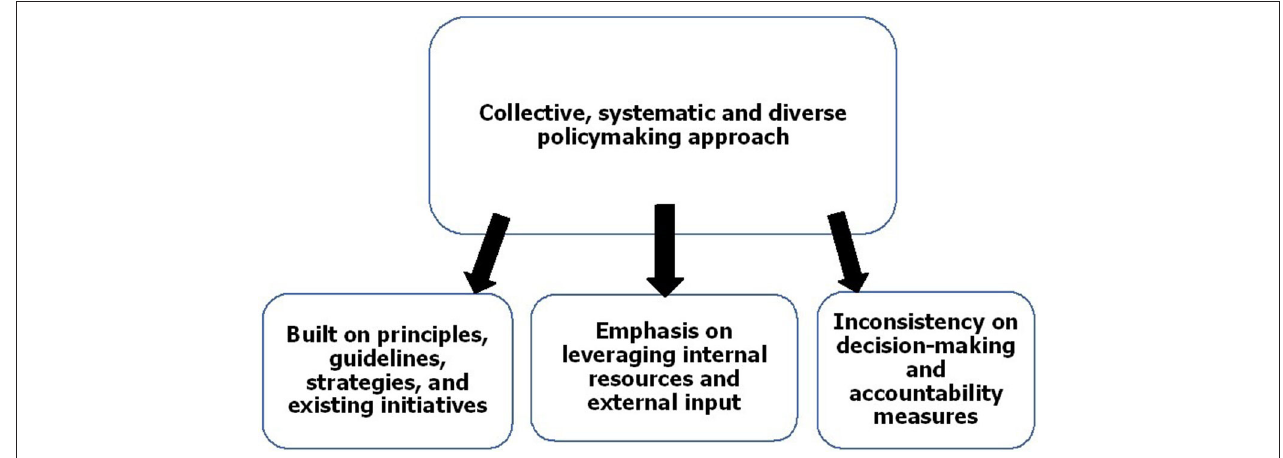
FIGURE 1 | Recurrent features of policy formulation and